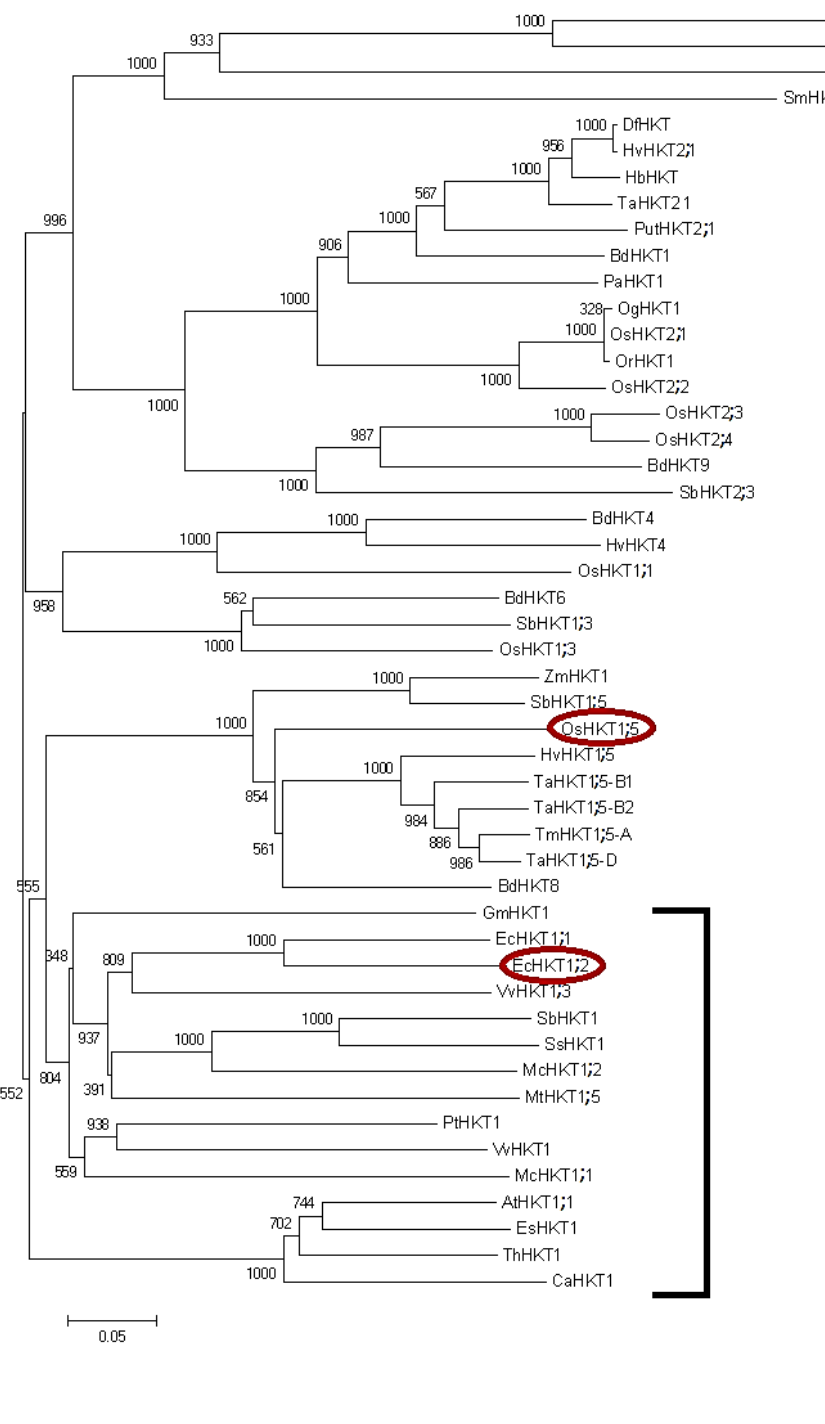
Figure 1. Phylogenetic analysis of plant HKT transporters. All published sequences were retrieved from the NCBI database and aligned with ClustalX2 [79]. The phylogenetic tree was constructed based on aligned protein sequences using Neighbour-Joining algorithm [80] with a Bootstrap value of 1000 using ClustalX2 [79]. The scale bar indicates the substitution rate per site. All dicotyledonous HKT entries (and none of monocotyledonous ones) are bracketed. The red circles denote proteins that are shown in Figure